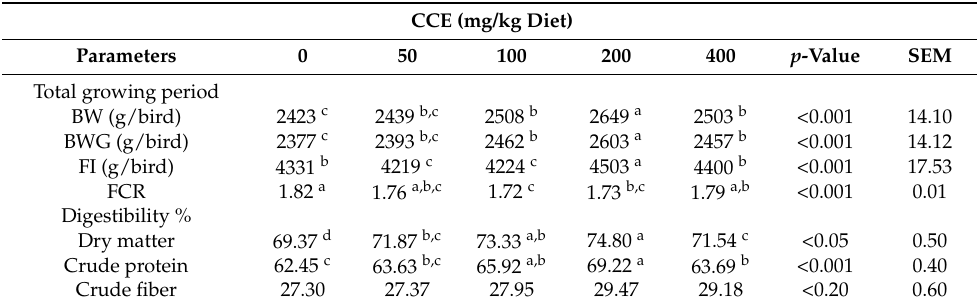
Table 3. Effect of different levels of cornelian cherry extract (CCE) on growth performance and nutrient digestibility of broiler chickens.